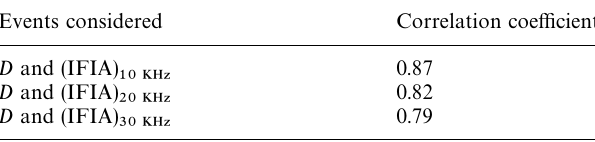
Table 6. Correlation coefficients between diffuse radiation and IFIA Events considered Correlation